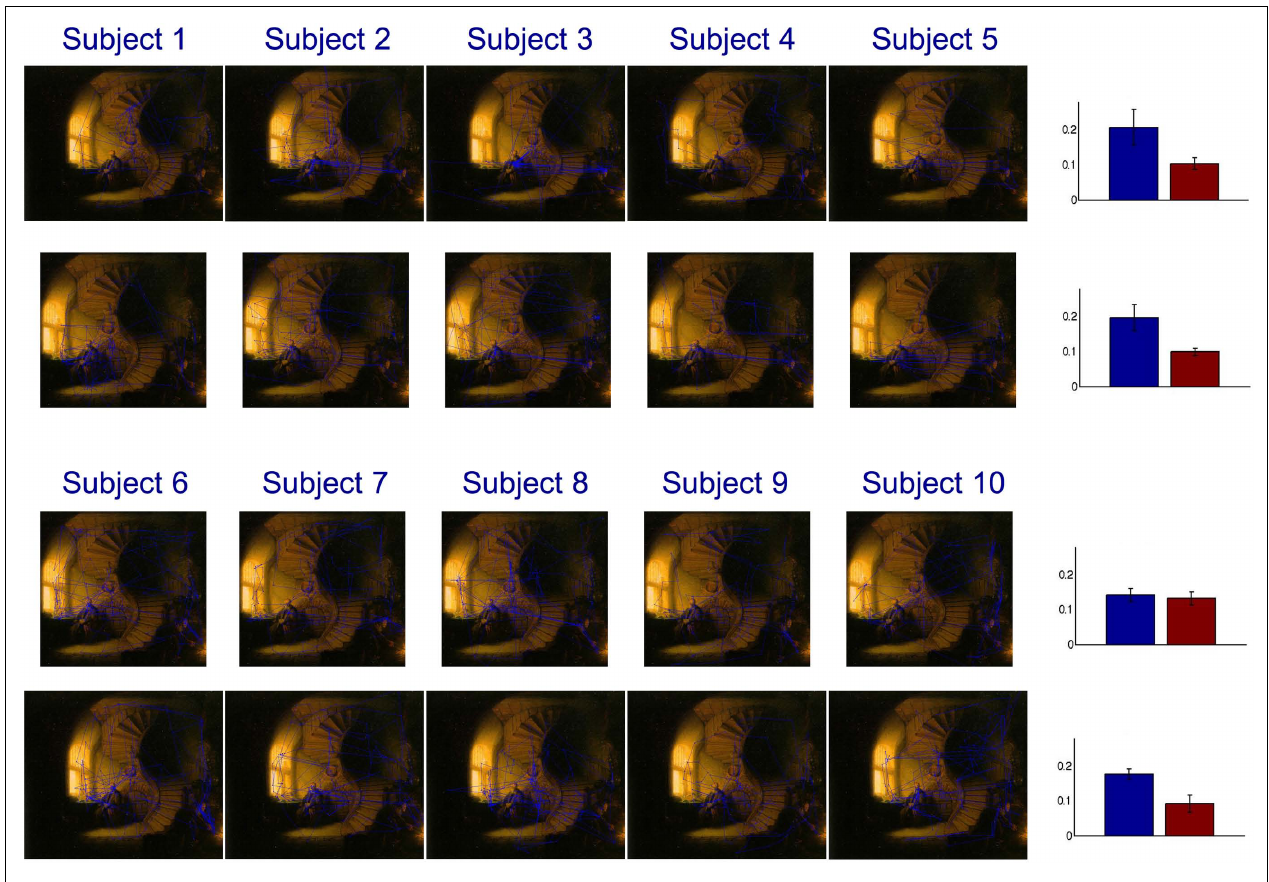
original (modified) version first.The graphs on the right of each row show the average relative number of fixations in each region of interest for the five